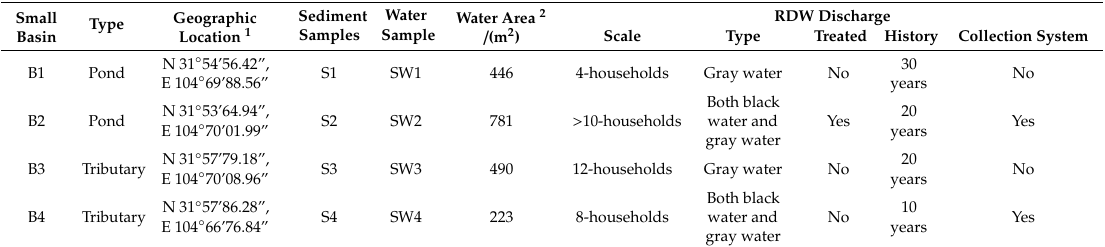
Table 1. Site information for the four small basins polluted by RDW (rural domestic